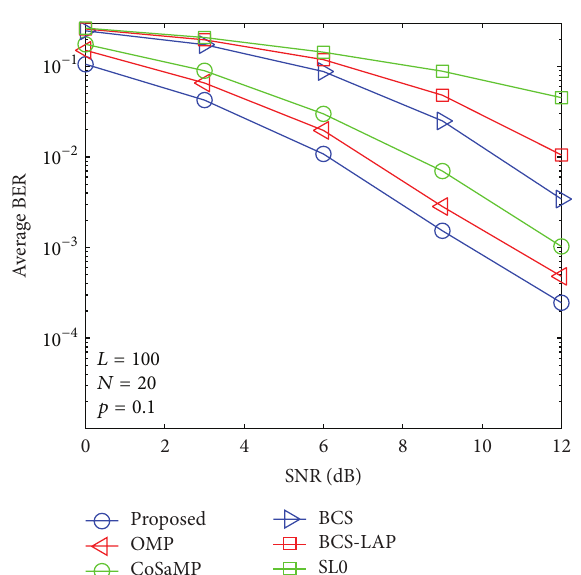
Figure 9: Average BER performance versus SNR when 𝑝 1 = 0.1 and 𝑁 = 20 .